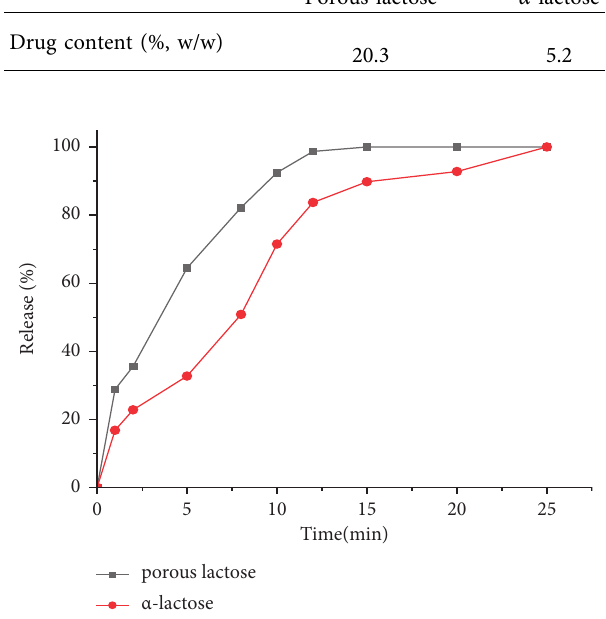
Table 2: Loading efficiencies of the porous lactose and α -lactose. Porous lactose α -lactose